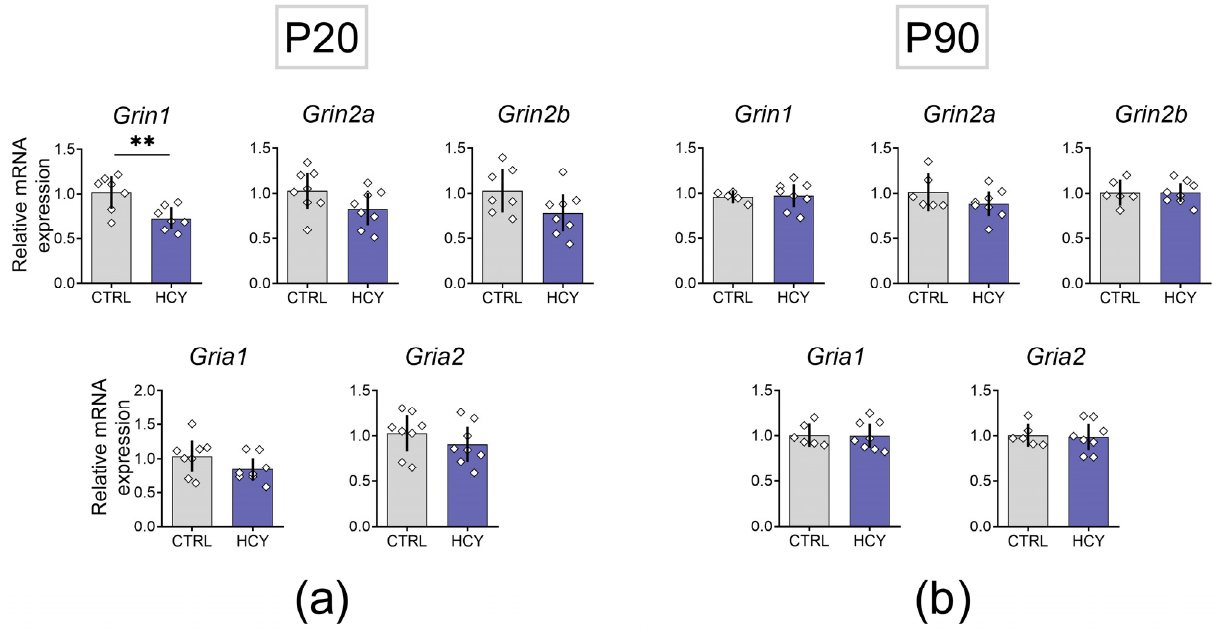
Figure 6. The relative mRNA expression of Grin1 , Grin2a , Grin2b subunits of NMDA receptors and Gria1 , Gria2 subunits of AMPA receptors in the dorsal hippocampus of HCY rats at P20 ( a ) and P90 ( b ). CTRL—control group, HCY—experimental animals. Unpaired t -test, ** p < 0.01.